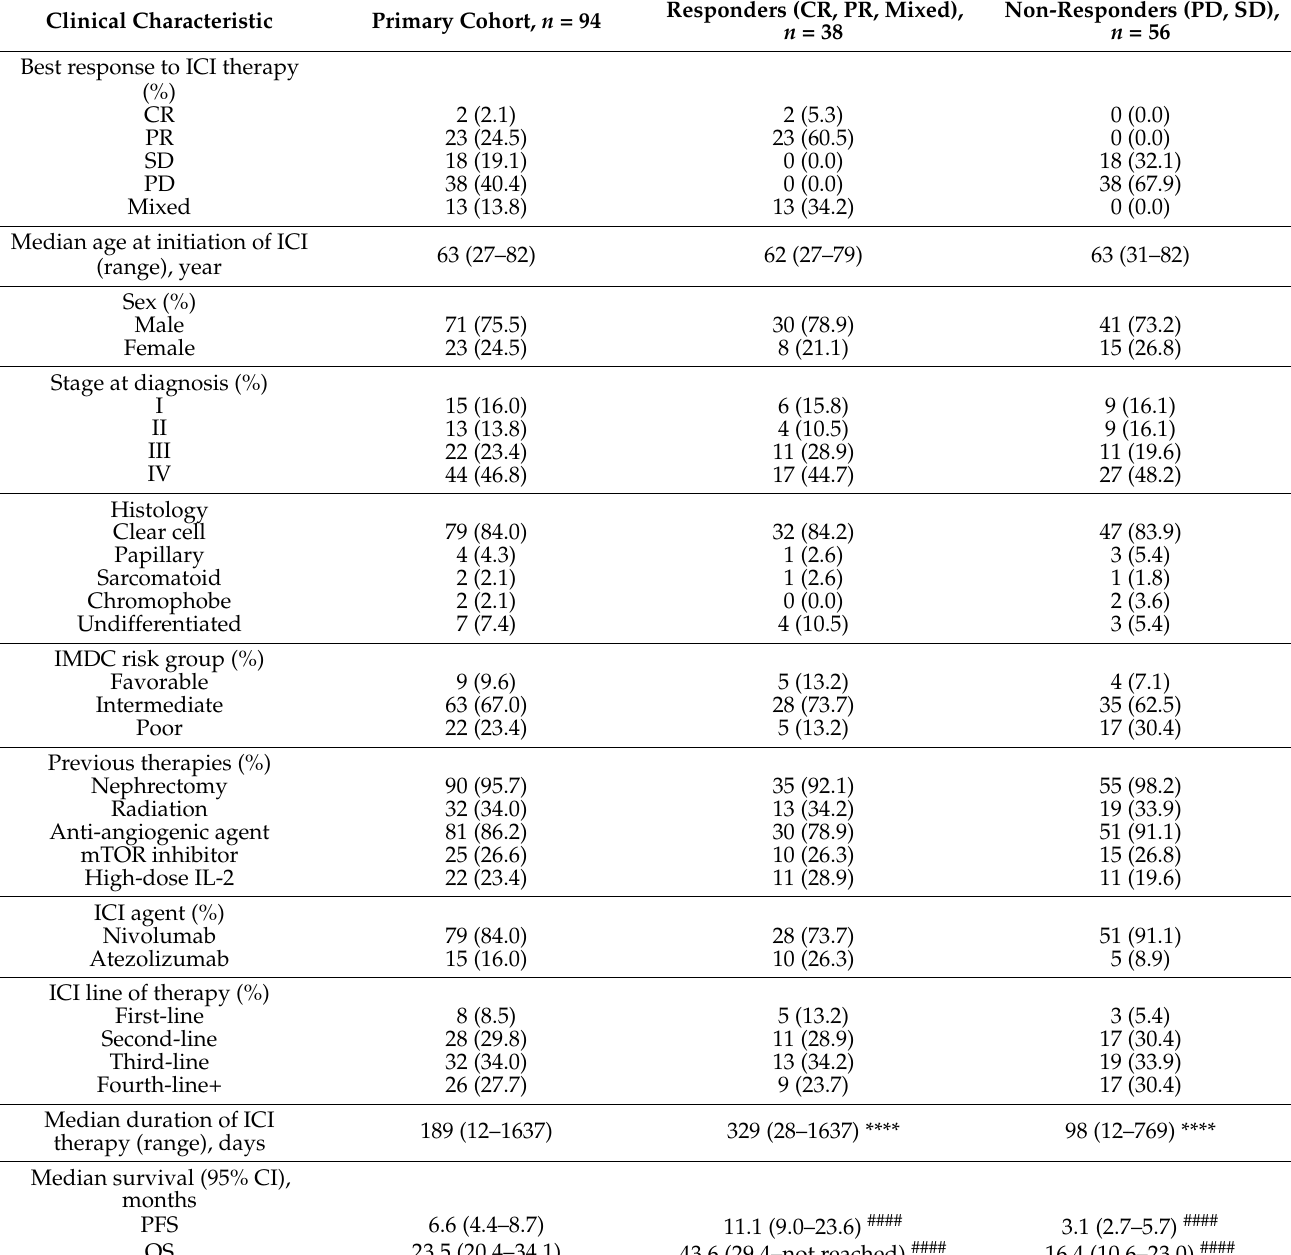
Table 1. Clinical characteristics of primary cohort of patients with